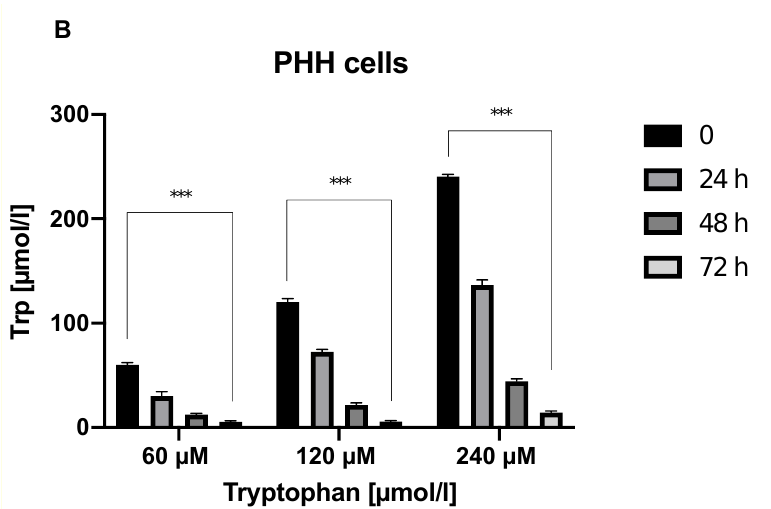
Figure 1. Trp levels in HepaRG ( A ) and PHH ( B ) cell supernatants over time. *** p < 0.001.